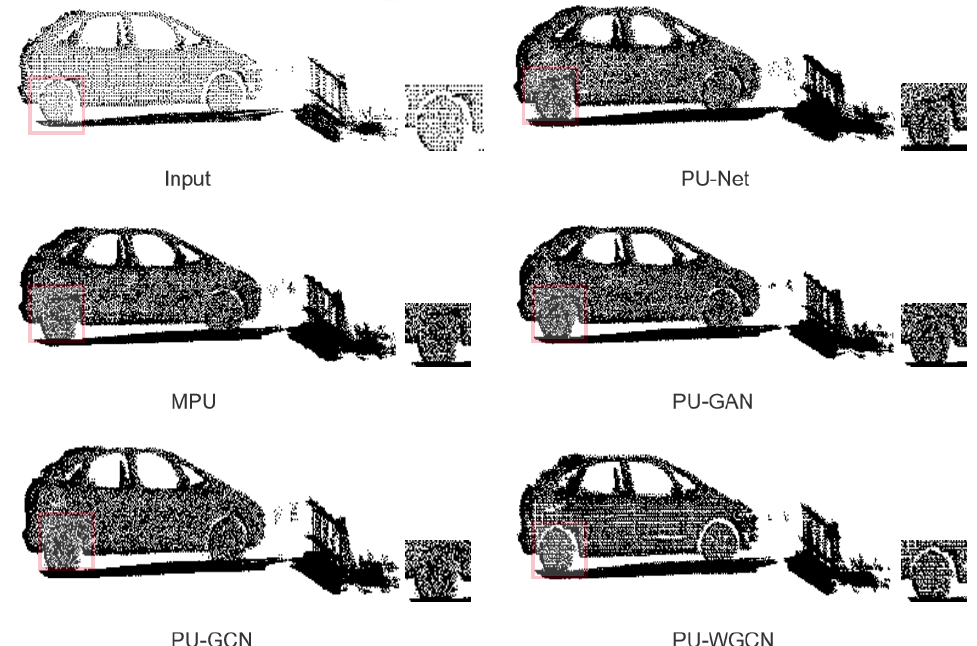
Figure 18. Visualization of the results in real scenes of group h. We perform upsampling operations on the car data. PU-WGCN retains the hole and boundary information of the car